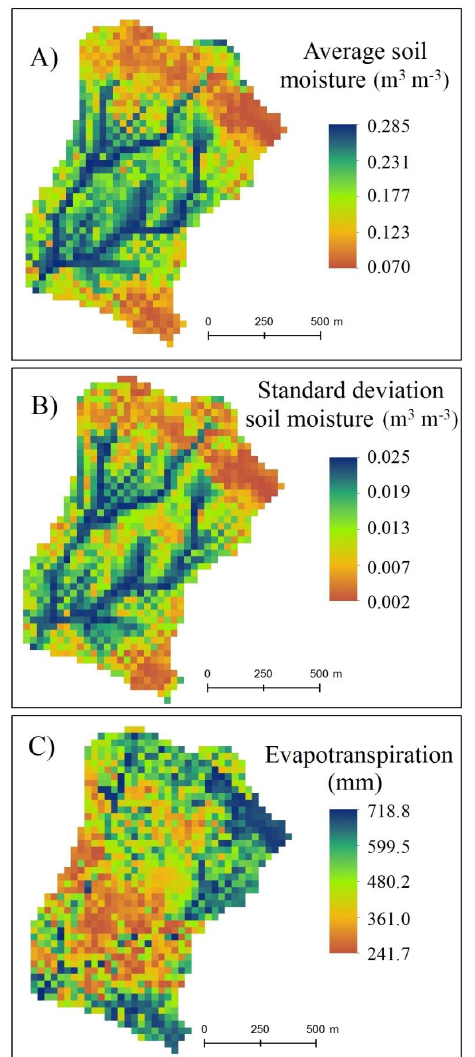
Figure 8. Simulated average pasture production and precipitation at Site 1 , A) at the annual timescale for 300 years. B) for ten years at the daily timescale (the green shade represents +/- 1 standard deviation of pasture production, and the blue bars is the rainfall)